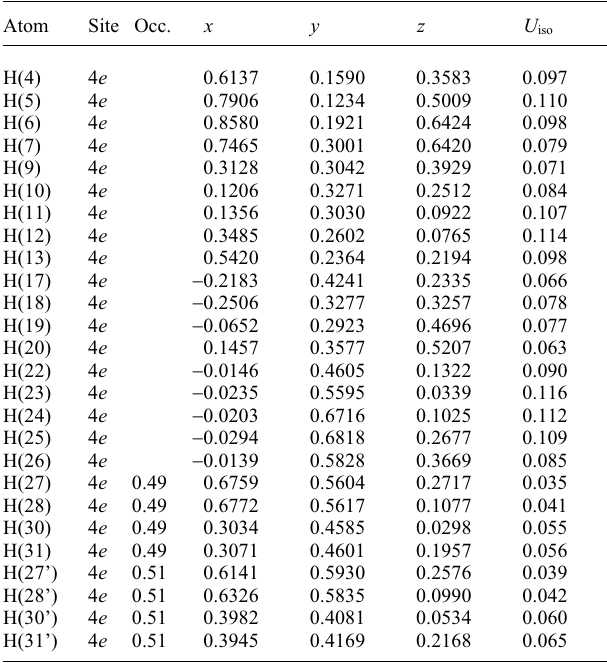
Table 2. Atomic coordinates and displacement parameters (in Å 2 )